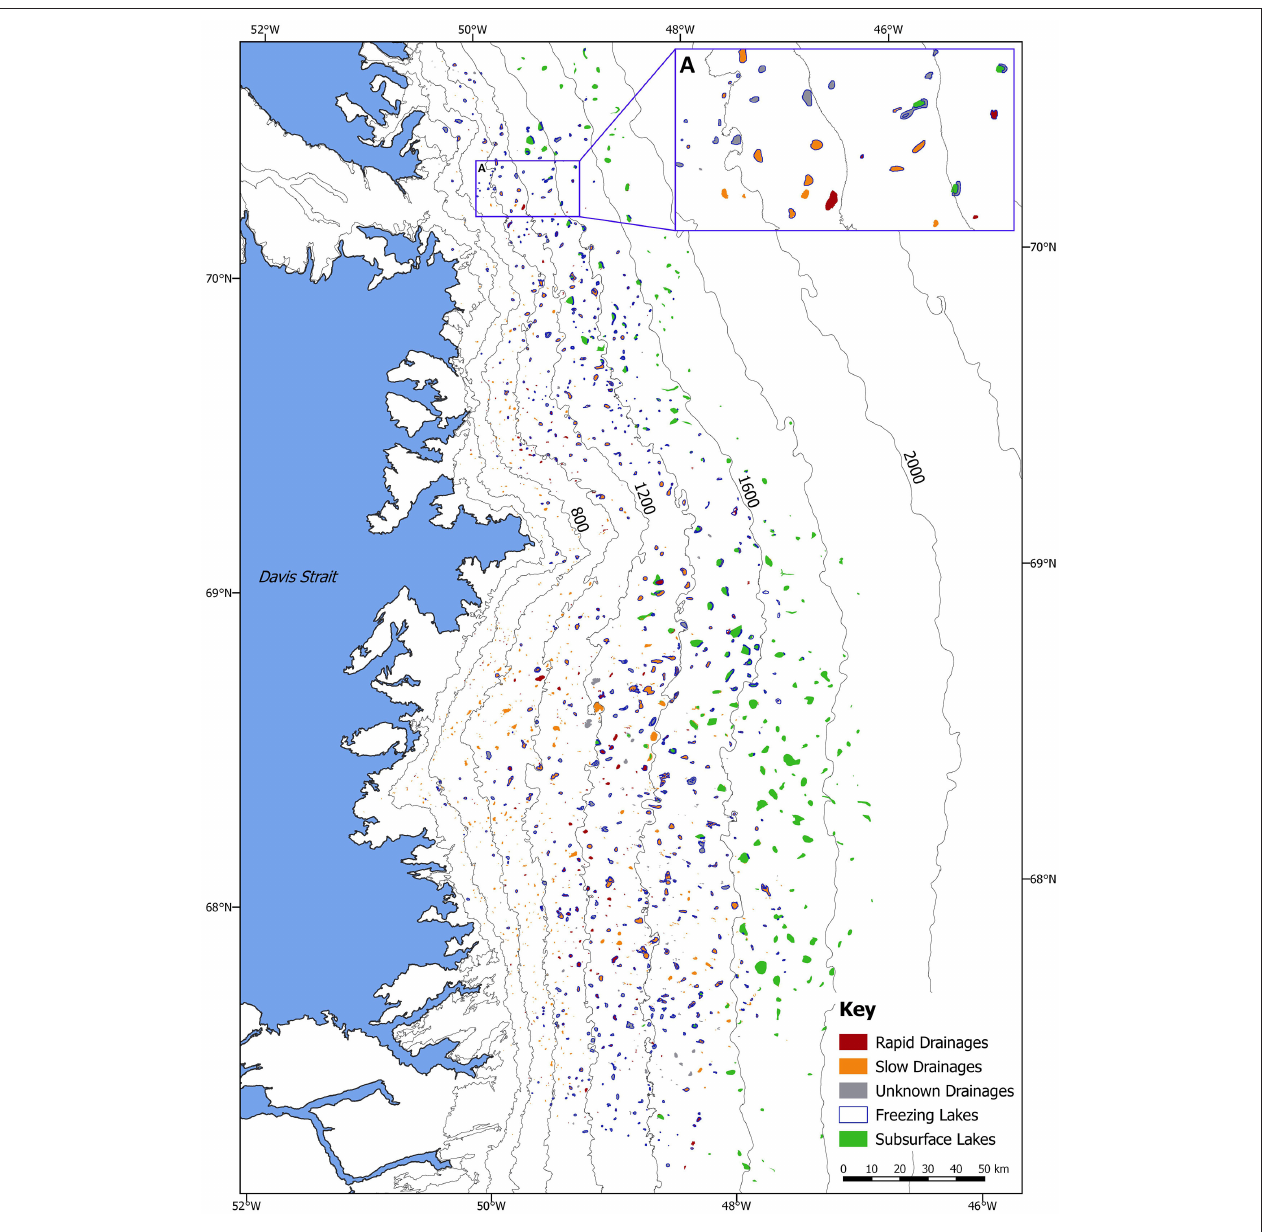
FIGURE 10 | All types of supraglacial lakes (surface and subsurface) plotted over the full study region shown in Figure 1 . Draining surface lakes are mapped using the combined Landsat–Sentinel-1 dataset; freezing surface lakes and subsurface lakes are mapped using the Sentinel-1 dataset only. Due to the overlap between the drainage and freeze-through datasets, grey, lakes with a blue border freeze-through only, whereas red and orange lakes with a blue border both drain and freeze-through during 2015. (A) Shows an enlarged subset of all lake